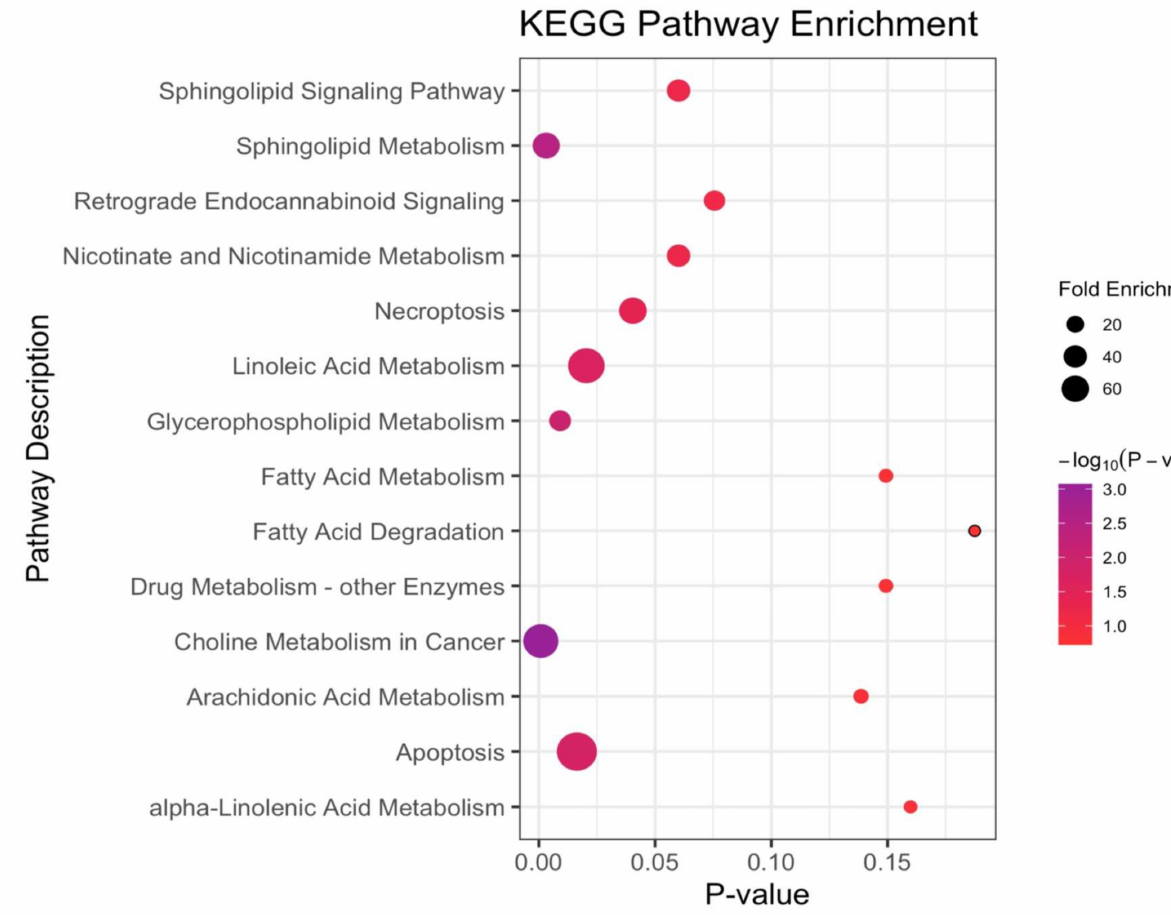
Figure 5. The disturbed metabolic pathways when comparing the NSCLC cases versus cancer-free controls. Various metabolism changes before a diagnosis with NSCLC was manifested (the p -value was calculated based on the hypergeometric distribution; fold enrichment was calculated based on the total number of metabolites mapped into the biochemical pathway; and the total number of compounds in the involved